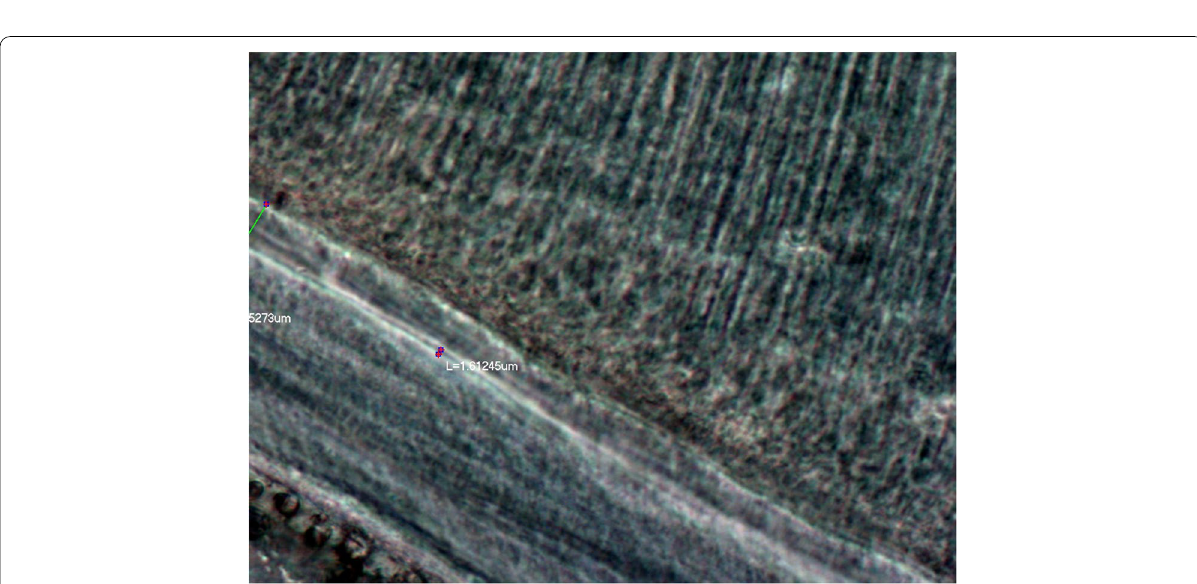
Fig. 4 Photomicrograph of periodontally diseased tooth showing measurement of the width between two incremental lines of cementum (ground section ×